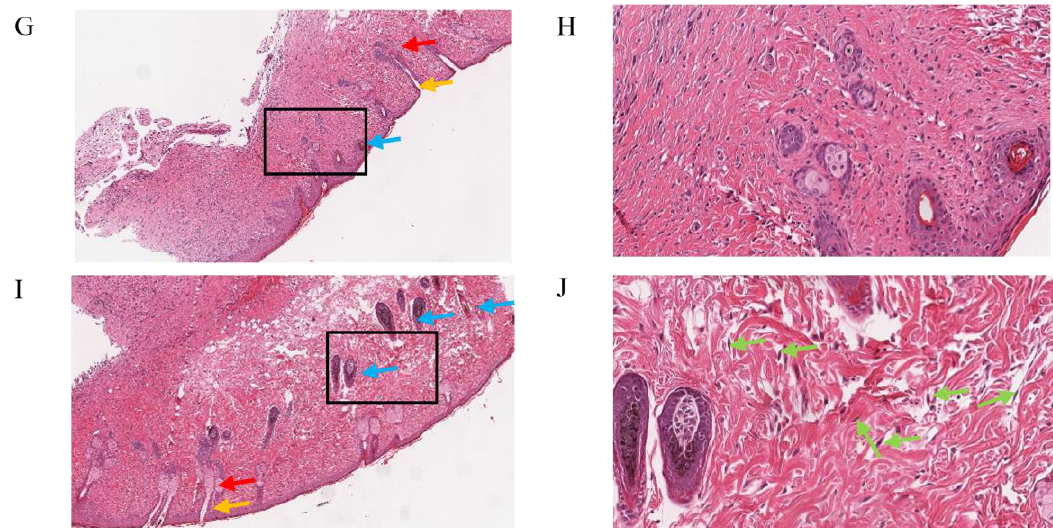
Figure 10. Histopathological examination of the healed tissue. Microscopic images of skin, hema- toxylin and eosin (H&E)-stained ( A ) (×200) and ( B ) (×400) model group; ( C ) (×200) and ( D ) (×400) CS group; ( E ) (×200) and ( F ) (×400) hydrogel group; ( G ) (×200) and ( H ) (×400) scolopin2 group; ( I ) (×200); and ( J ) (×400) the multifunctional hydrogel (CS-GA-S) group. Blue arrows represent blood vessels, red arrows represent sebaceous glands, orange arrows represent hair follicles, and green arrows represent fibroblasts.